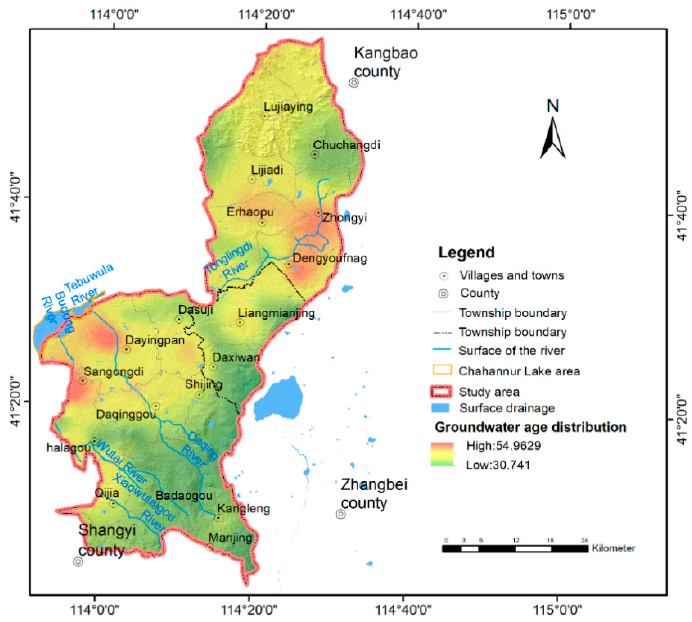
Figure 5. CFCs groundwater age distribution.